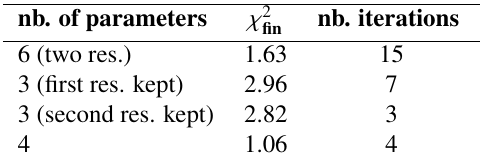
Table 1. Summary of adjustments on 23 Na( n , tot) measurement nb. of